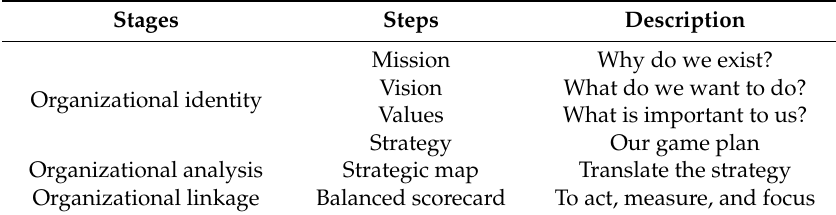
Table 1. Sequential description of organizational analysis